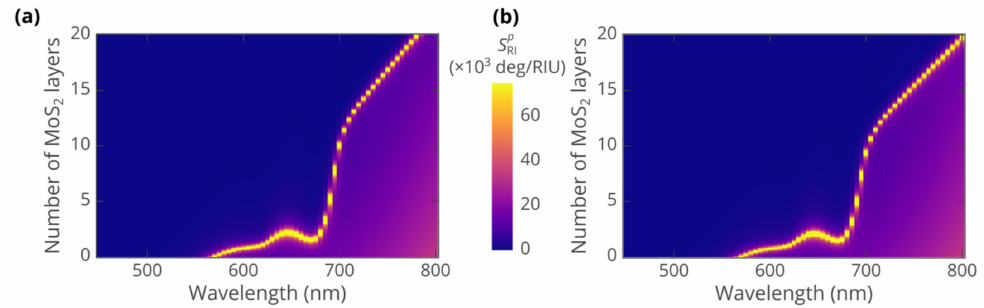
Figure 5. Heatmaps of phase sensitivity as functions of the number of atomic layers in MoS 2 film and the operating wavelength. Calculations were performed using: ( a ) full anisotropic dielectric tensor and ( b ) isotropic dielectric permittivity for the MoS 2